Question: Looking at the figure, what chart type is it?
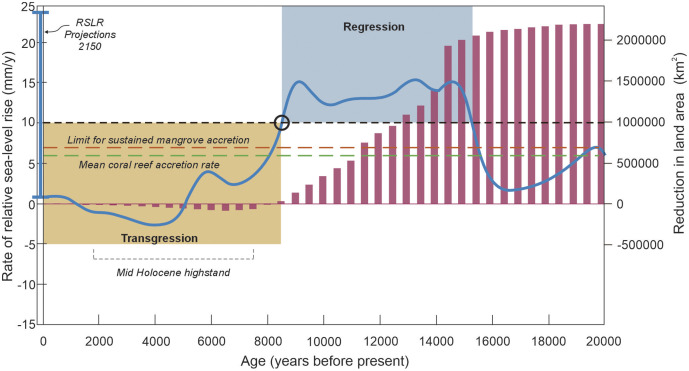
Answer: bar